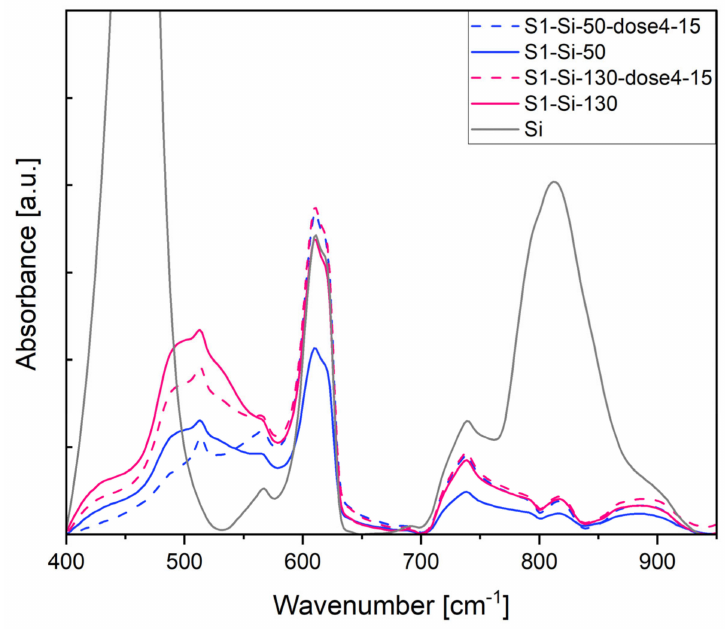
Figure 11. Absorbance of first series CuO samples on Si, measurement in IR transmission